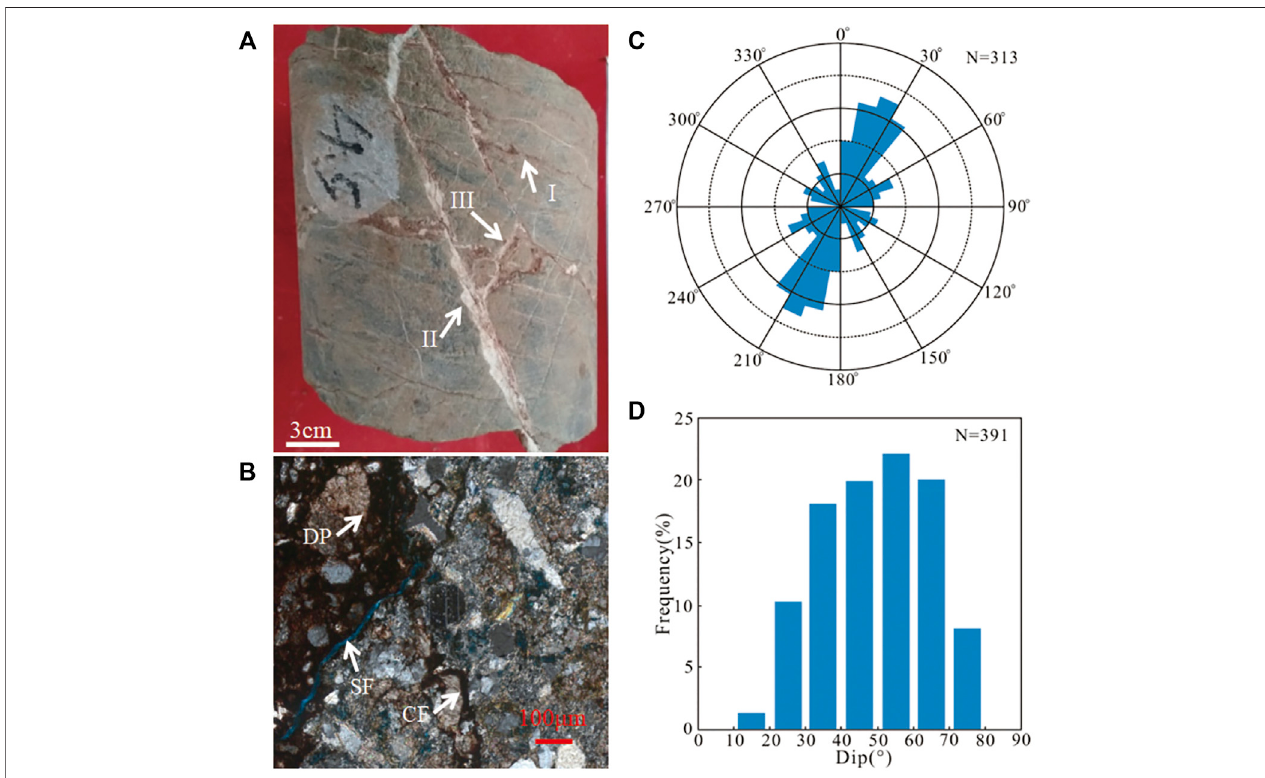
FIGURE 5 | Fracture characteristics in slate. (A) Fractures are completely fi lled with minerals in the weathered layer. Well W18: depth 1847.6 m. (B) Shear fracture observed from thin sections. Well W2: depth 1848.4 m. (C) Rose diagrams of natural fracture strike in slate from FMI. (D) Dip angles of natural fracture in slate from FMI data and cores. See Figure 1 for wells